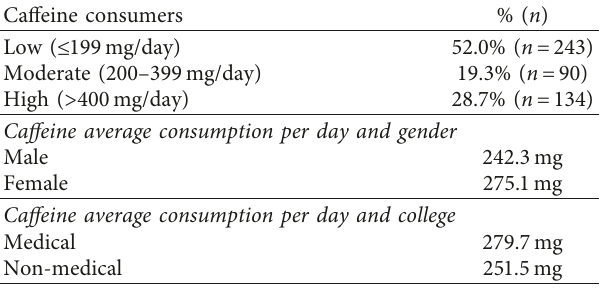
Figure 1: Reasons for caffeine consumption (expressed as %). Table 6: Caffeine average